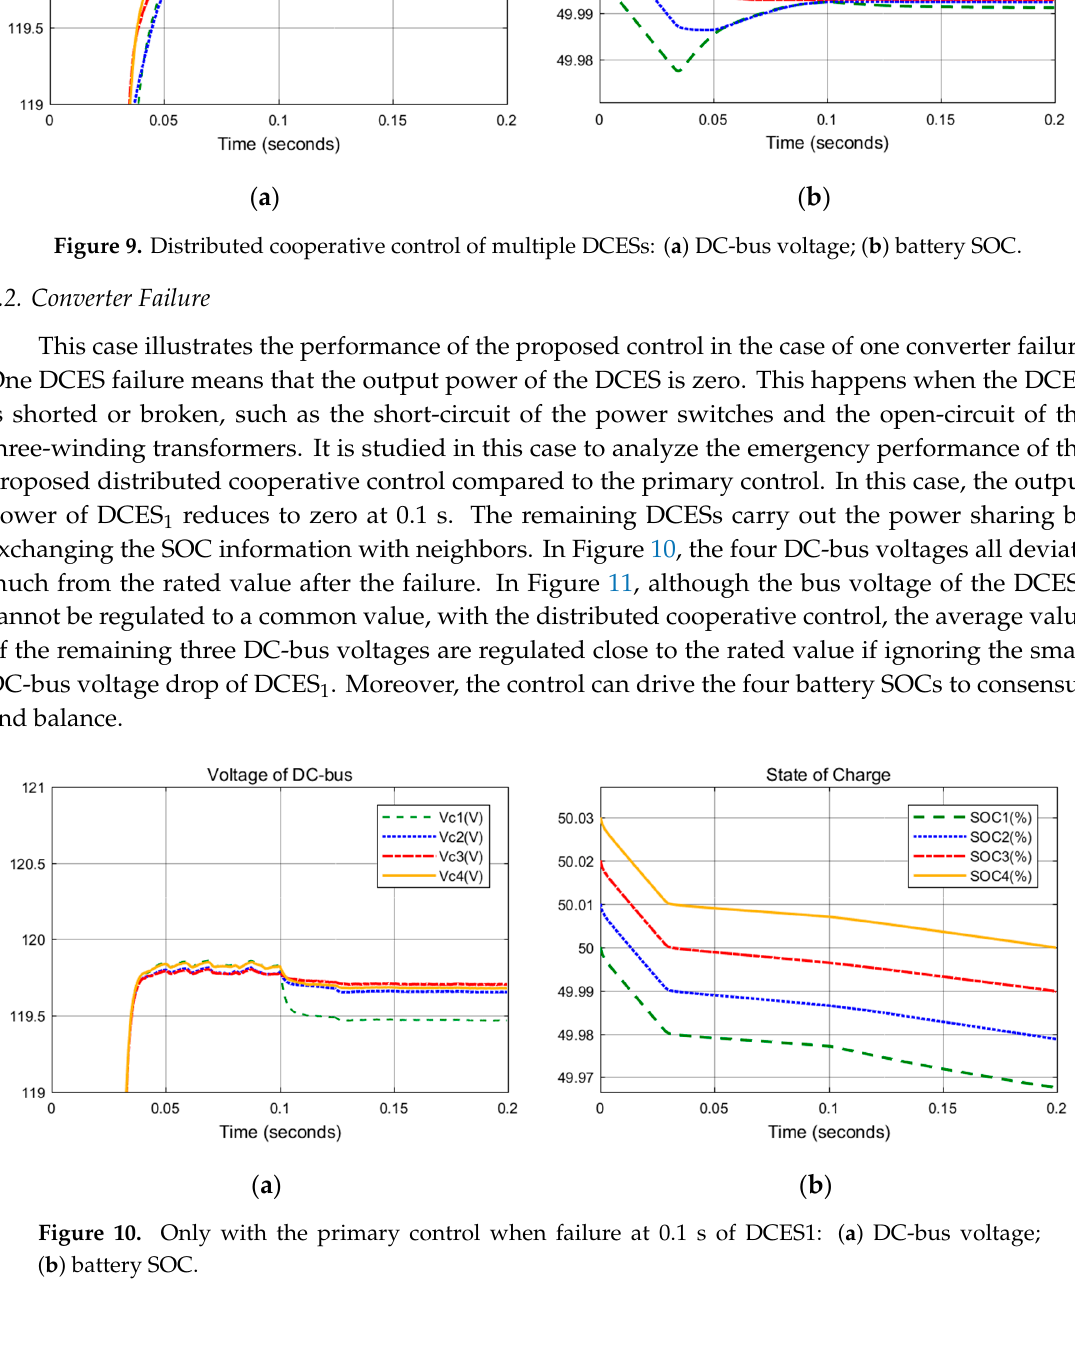
Figure 9. Distributed cooperative control of multiple DCESs: ( a ) DC-bus voltage; ( b ) battery SOC.